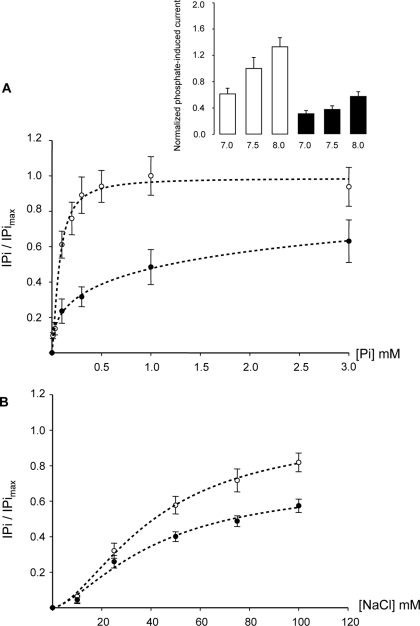
Kinetic analysis of inorganic phosphate transport in oocytes expressing NPT2a or co-expressing NPT2a and CFTR.Phosphate-induced currents (IPi) were measured (Vc =  −50 mV) in NPT2a-oocytes (empty circles) and in NPT2a+CFTR-oocytes (filled circles). The dashed lines through the points (means ± SEM from n  =  6 to 14, N  =  5) were calculated using SigmaPlot software (Systat software Inc., San Jose, CA). A: IPi was induced by increasing Pi concentration in ND 96, pH 7.5, as indicated in abscissa and normalized against extrapolated maximal current (IPimax). Data were fitted to Michaelis-Menten equation. Results, as means ± SD, were as follows: the apparent concentration of Pi substrate (Km) giving the half IPimax was not changed by CFTR expression (Km  =  0.07± 0.02 vs 0.06 ± 0.02 mM in NPT2a- and NPT2a+CFTR-oocytes, respectively), but IPimax was decreased by 40±3% (P <0.05). B: IPi was induced by 1 mM Pi at increasing Na+ concentrations (equimolary substituted by choline+, pH 7.5) and normalized against IPimax. Data were fitted to the modified Hill equation. Results, as means ± SD, were as follows: the apparent Km for Na+ substrate was 40.7 ± 14.6 in NPT2a-oocytes, not different from 41.8 ± 13.4 mM in NPT2a+CFTR-oocytes; IPimax was decreased by 39±7% in NPT2a+CFTR-oocytes compared to NPT2a-oocytes (P < 0.05). Inset: Effect of varying extracellular pH from 7.0 to 8.0 on the current induced by 1 mM Pi in NPT2a-oocytes (white column) and in NPT2a+CFTR-oocytes (black column). IPi was normalized against the Pi-induced current measured at pH 7.5 in NPT2a-oocytes from the same batch of oocytes. Results are shown as means± SEM, n  =  5 oocytes of each type.